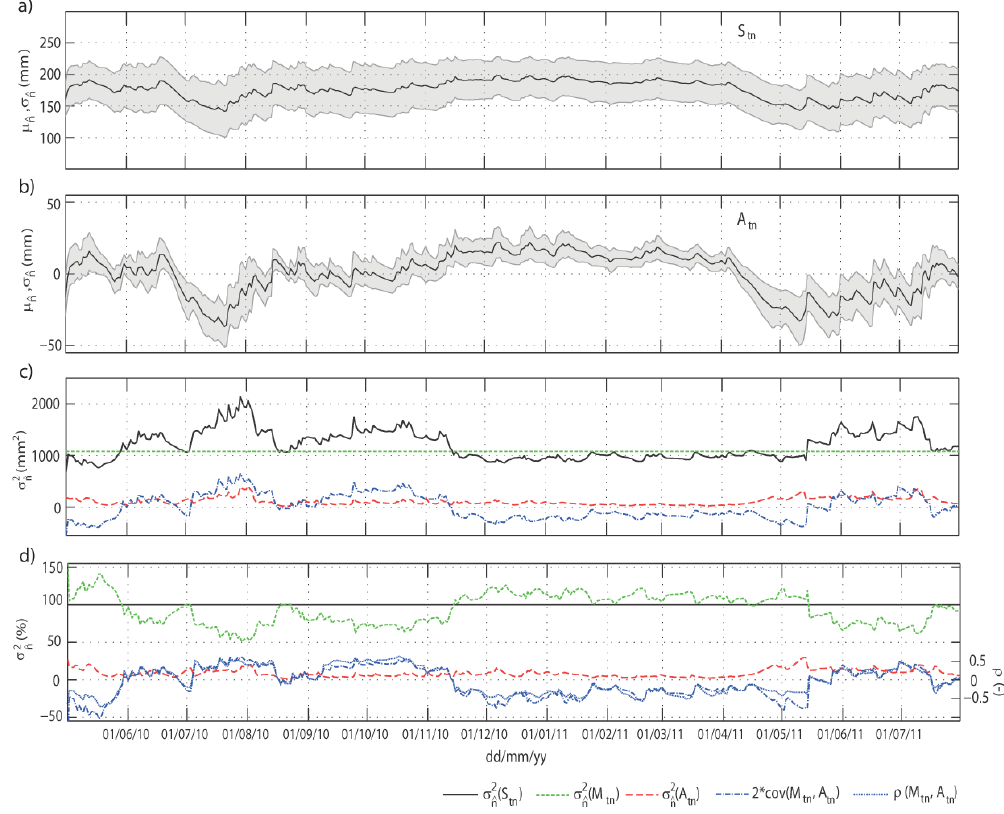
Fig. 4. Time series of spatial mean and spatial standard deviation (shaded areas) for (a) absolute soil moisture S tn , and (b) anomalies A tn of absolute soil moisture. Decomposition of spatial variance of absolute soil moisture into its contributors according to Eq. (8) expressed (c) in mm 2 and (d) as